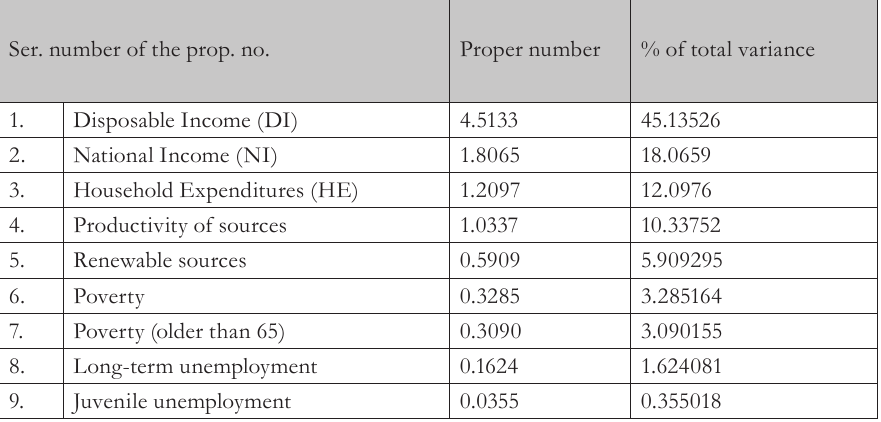
Tab. 3 – Values of the correlation matrix for the indicator of efficient competitiveness. Source: authors’ processing using Eurostat, AMECO, World Bank (2016) Ser. number of the prop.